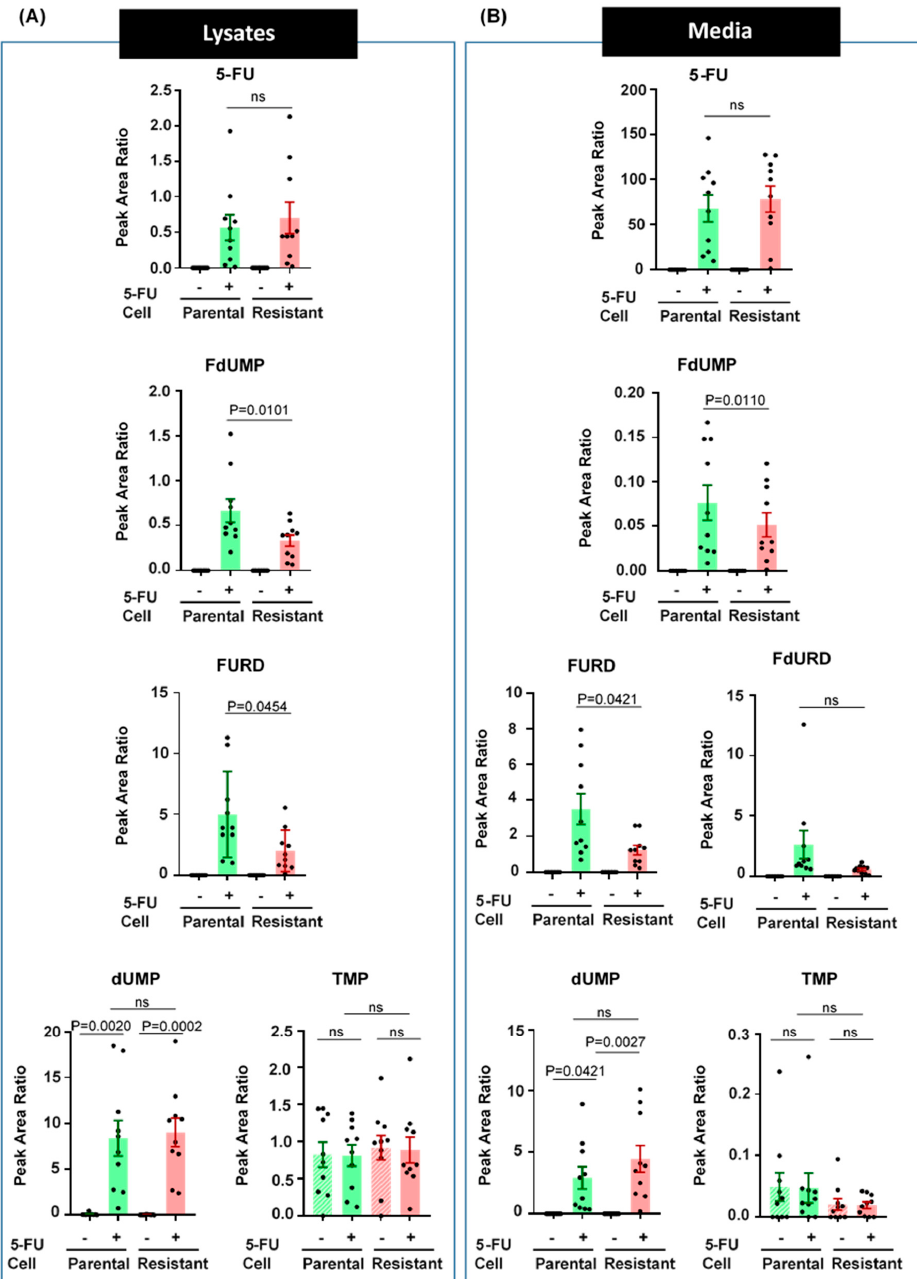
Figure 6. 5-FU metabolism is dysregulated in resistant cells. To analyze the metabolism pathway of 5-FU in parental and resistant cells, LIM1215 cells were cultured in media with and without 50 µM 5-FU for 72 h. Media and cells were collected, and the metabolites were extracted. Trypan blue cell counting was used to determine the cell concentration and an equal number of cells were resuspended in methanol and mechanically lysed to extract the metabolites. Samples were subjected to tandem mass spectrometry coupled to F5 phased UHPLC. Raw data were processed and analyzed using bioinformatics tools, particularly, Skyline. Quantitation was based on the peak area obtained from Skyline and the comparison was normalized relative to the peak area of 0.780 ng / µ L FdUMP standard. The graphs represent levels based on the peak area ratio of 5-FU and reduced levels of metabolites in resistant cells compared to parental cell lysates ( A ) and media ( B ), revealing that the 5-FU metabolism pathway is impaired in resistant cells. ns; not significant. Data is presented as mean ± s.e.m. determined by Student’s t-test (n =